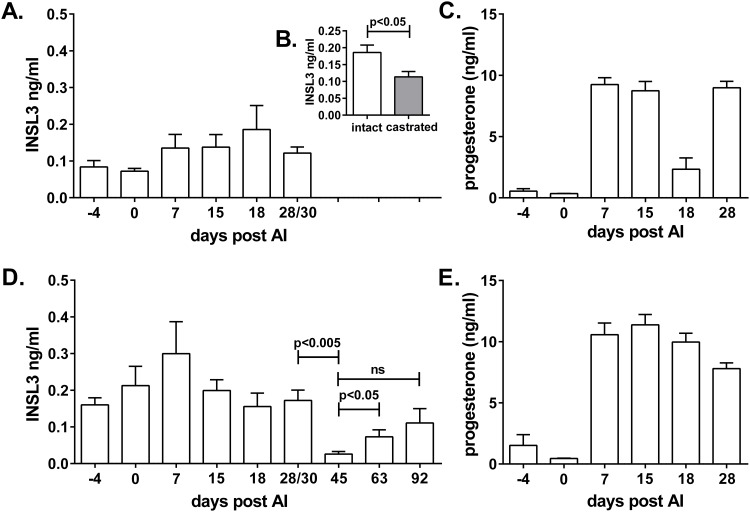
Circulating INSL3 (A,B,D) or progesterone (C,E) in conceptive (D,E) (n = 11) and non-conceptive (A,C) (n = 12) cycles of gilts subjected to hormonal synchronization and artificial insemination (AI) or not.Panel D also includes INSL3 values from later in pregnancy (n = 4–5). Panel B indicates maternal plasma values for pregnant gilts (n = 12) on day GD15 (intact) and following ovariohysterectomy that day with blood sampling 11–13 days later (castrated).